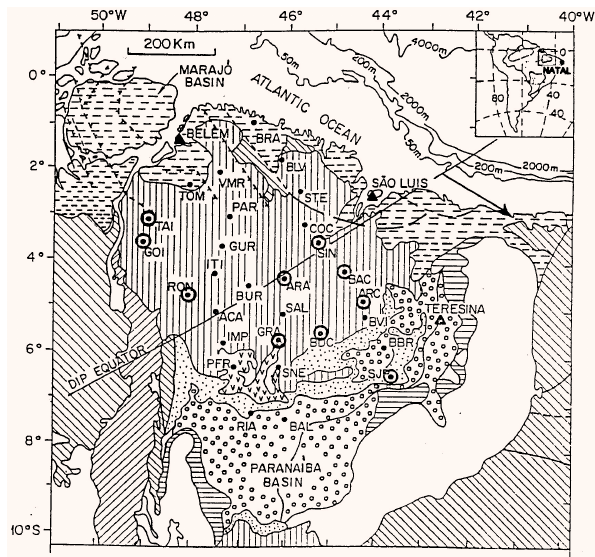
Fig. 1. Map of N-NE Brazil showing the location of magnetometer sites in relation to the dip equator. Stations that recorded the Pc5 Pulsations associated with magnetic storm of 24 March 1991 are circled. Inset shows the location of study area on the map of South America. Location of station Natal, in relation to the array area, is also marked in the inset. Exact location of Natal is positioned at a distance of four times the length of the arrow, along the direction of arrow.